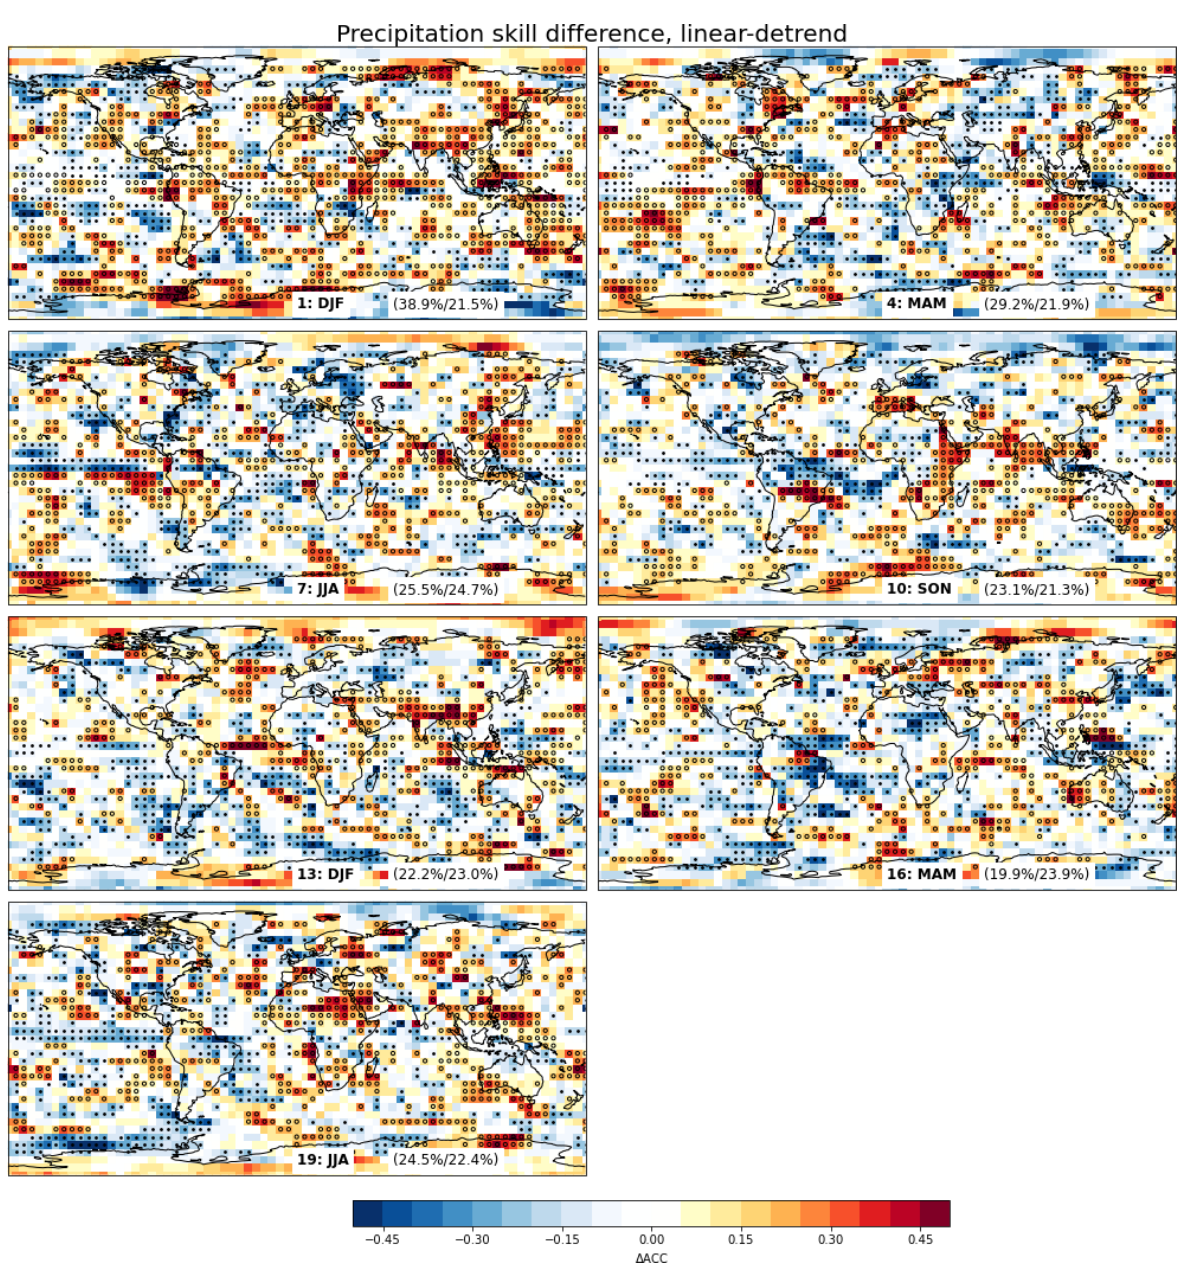
Figure B4. Difference in ACC skill for precipitation between SMYLE-NOV and the mean of the 20-member skill score distribution from DPLE-NOV. Here, both hindcast sets use identical verification windows (corresponding to start dates spanning 1970–2017). Open and filled circles indicate significantly higher and lower ACC in SMYLE-NOV, respectively (corresponding to SMYLE-NOV skill falling above the 90th or below the 10th percentile of a 100-member distribution of 20-member DPLE-NOV scores). Values in parentheses give the percentage of global surface area (within 80 ◦ S–80 ◦ N) where there is significant skill